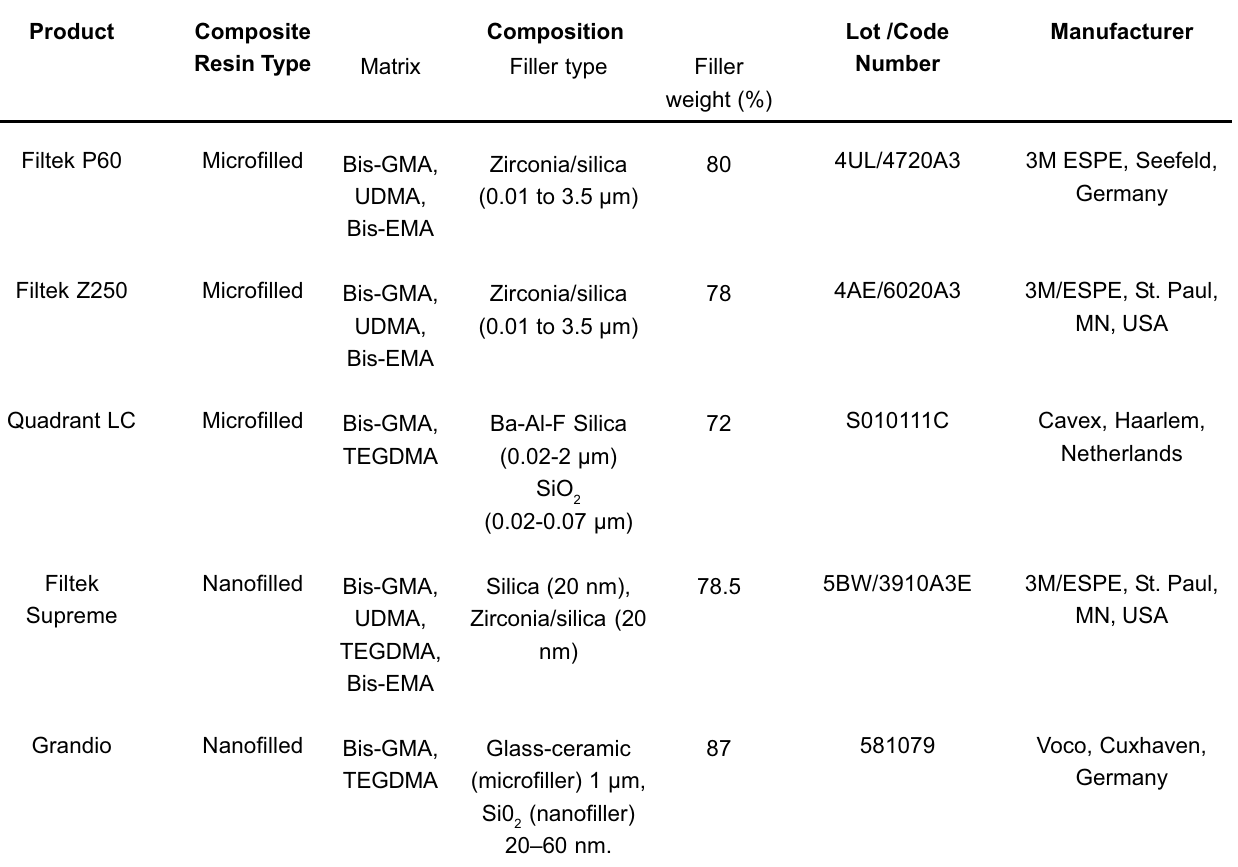
TABLE 1- Materials used in